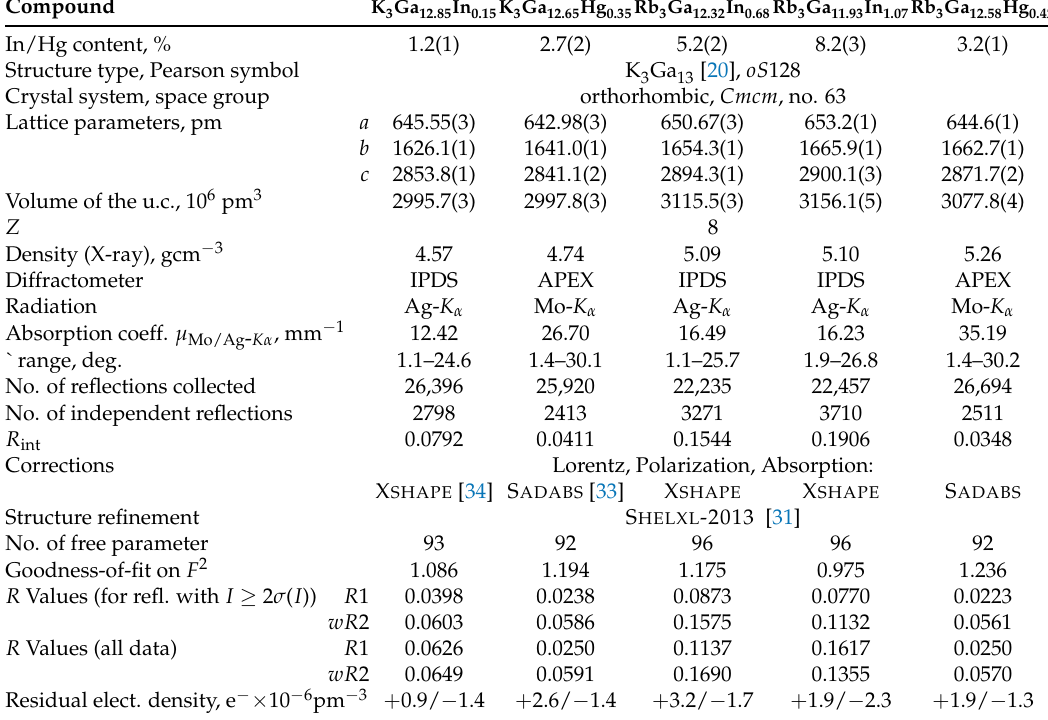
Table 6. Crystallographic data and details of the data collection and structure refinement of the ternary K Ga -type 3 13